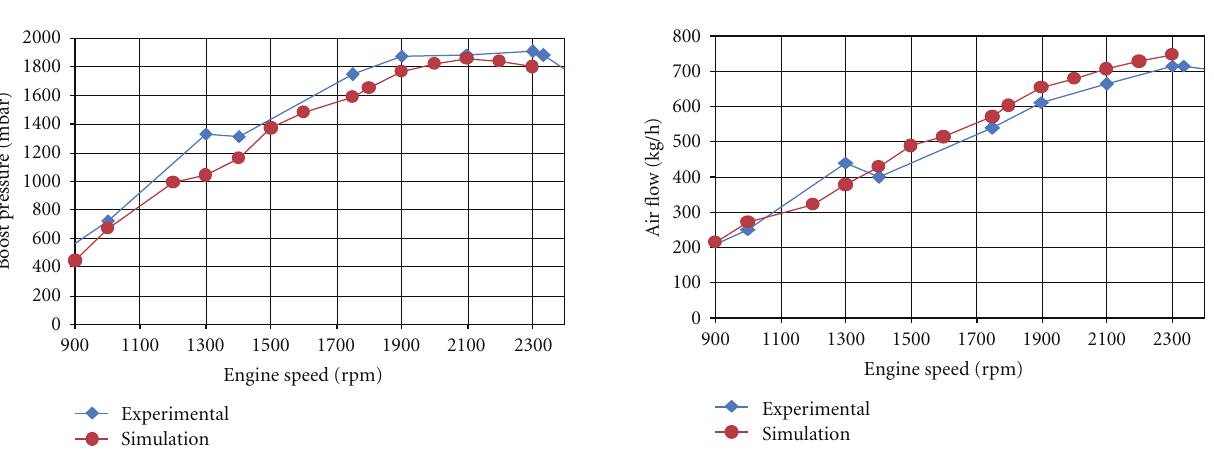
Figure 7: Comparison of experimental and simulated values of boost pressure.